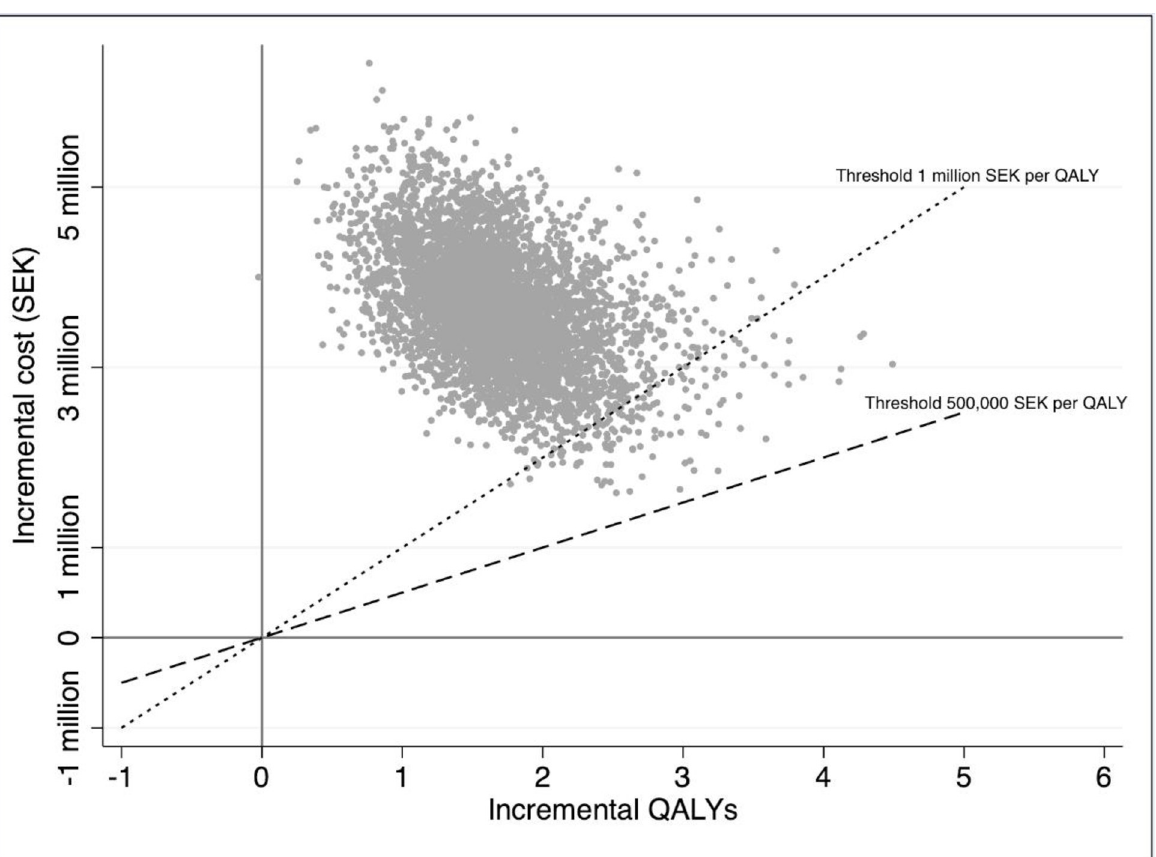
Fig 3. Cost-effectiveness plane based on probabilistic sensitivity